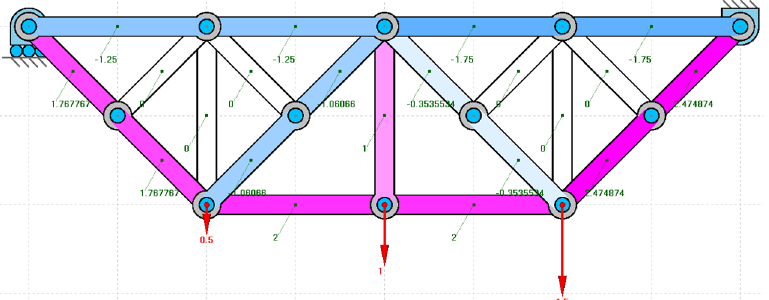
Figure 15. Axial forces of isostatic structure.